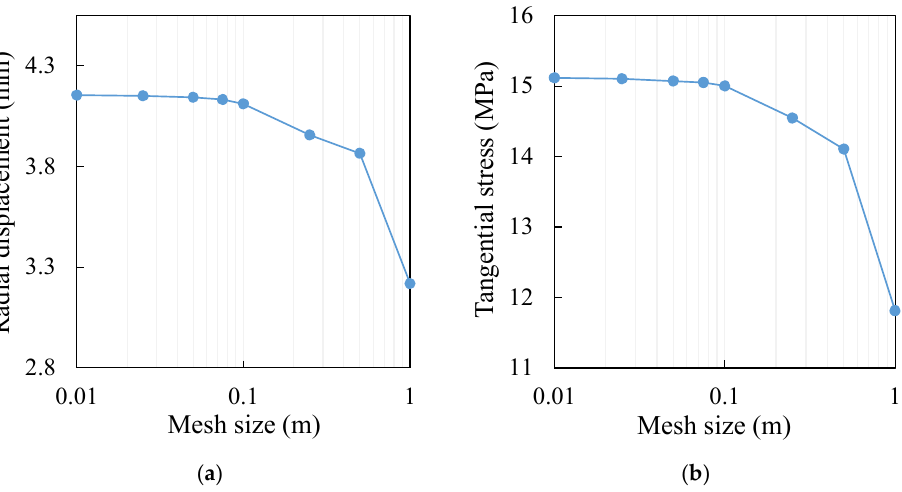
Figure A4. Variations of ( a ) radial displacement and ( b ) tangential stress at point M as functions of mesh size.